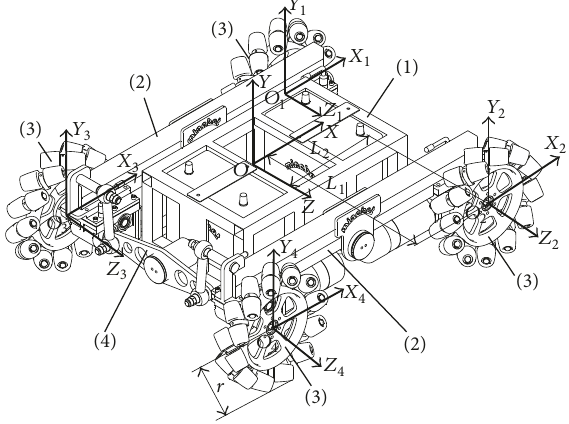
Figure 1: 3D model of the MWP. (1) Main body. (2) Rocker arm. (3) Mecanum wheel. (4) Differential mechanism.